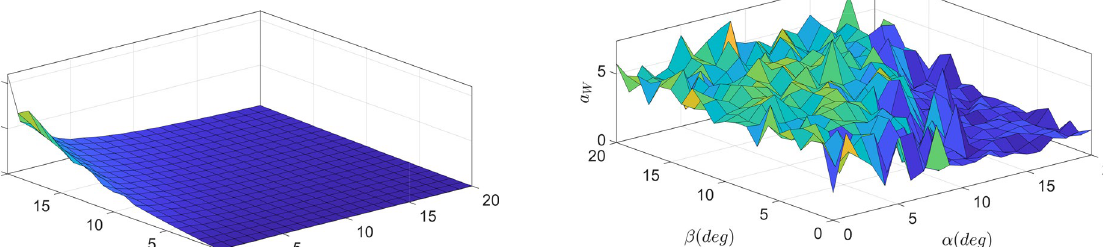
Fig. 17 Wang “ a W ” parameter